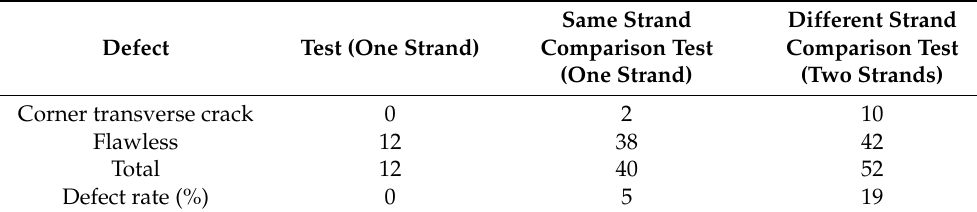
Table 5. Industrial test results.